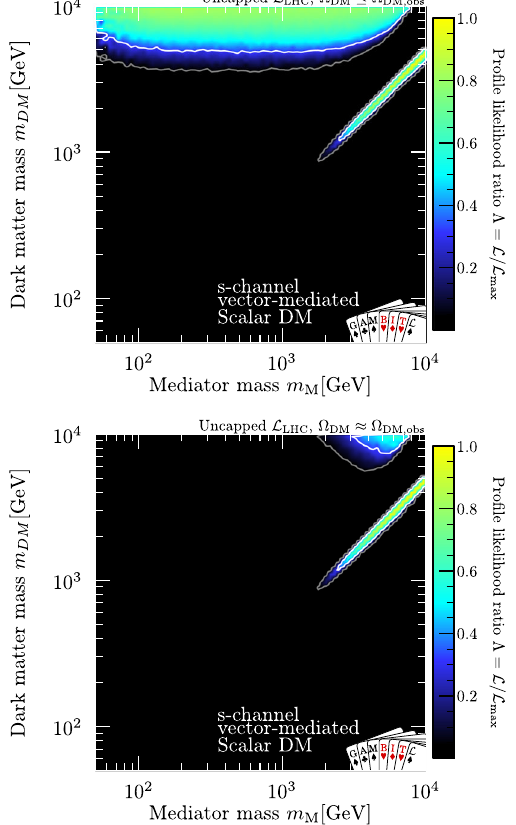
Fig. 2 Scalar DM profile likelihood, profiling over couplings. The observed relic density of DM is taken as an upper limit (top) or to con- sist entirely of the scalar DM candidate (bottom). 1 σ and 2 σ contours are shown in white and grey